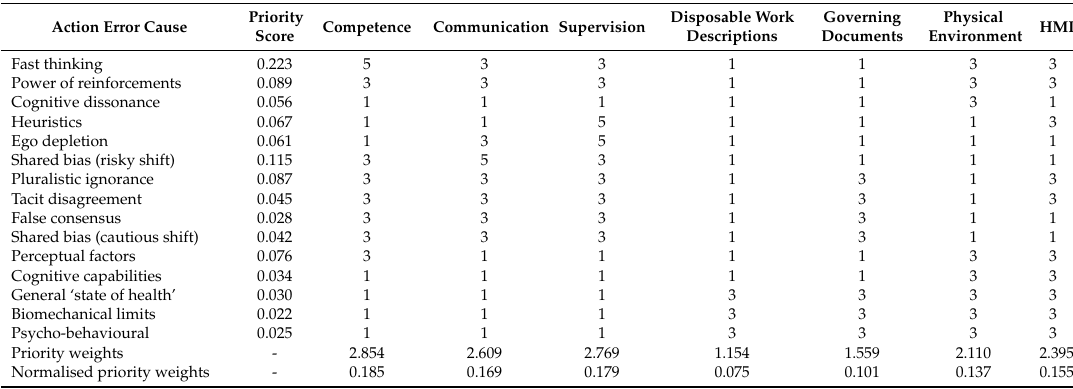
Table 8. Case study: Evaluation of the second relationship